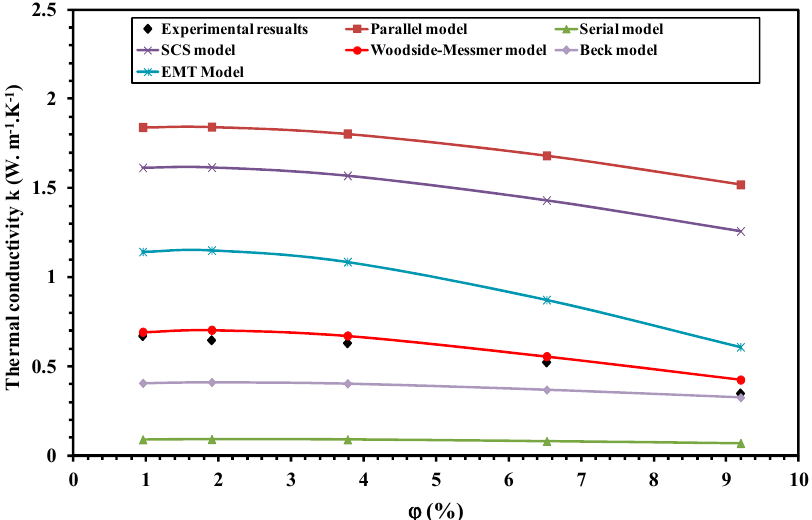
Figure 9. Comparison between measured and calculated thermal conductivities of AFRM composites as function of φ .